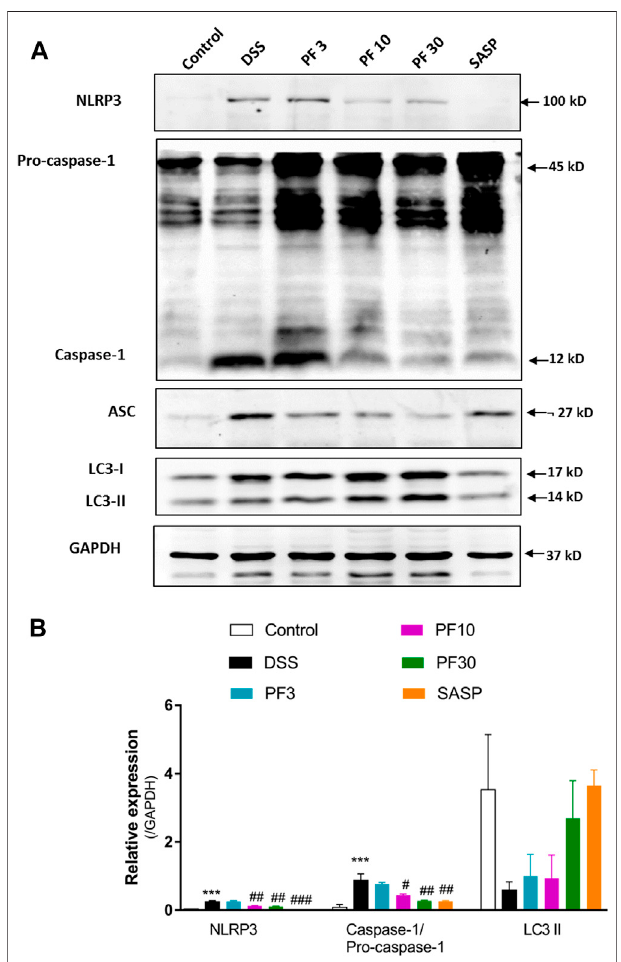
FIGURE 4 | PF-04447943 prohibited in fl ammasome activation in DSS- induced experimental colitis (A) Western blot analysis NLRP3, caspase-1, ASC, LC3, and GAPDH in colon homogenate (B) Relative expression of NLRP3, caspase-1, ASC, LC3 protein, respectively. Data are presented as mean ± standard error mean (SEM) (n (cid:1) 2). Here, *** p < 0.001, ** p < 0.01, * p < 0.05 vs. control group and ### p < 0.001, ## p < 0.01, # p < 0.05 vs. DSS- treated